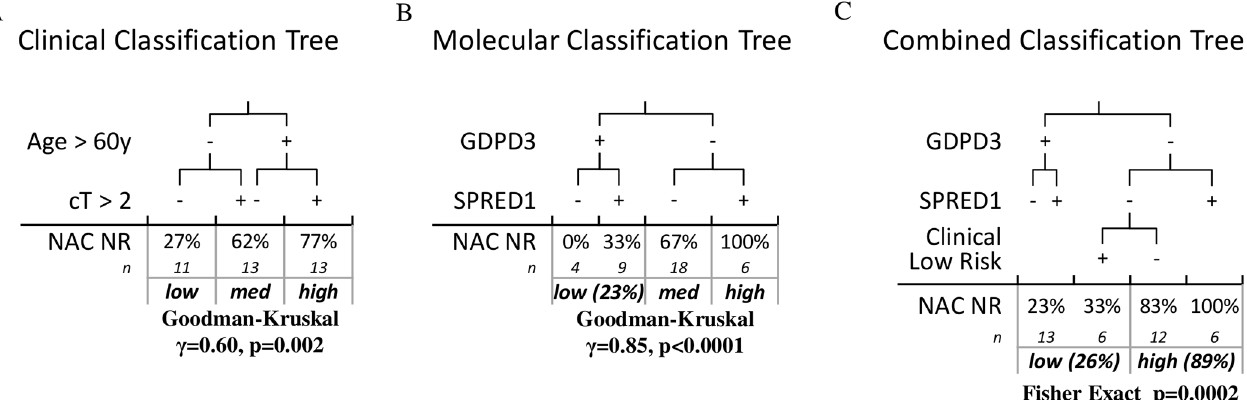
Fig 3. (A) The application of a previously developed classification tree based on the clinical parameters of age greater than 60 and clinical stage greater than cT2 is significantly associated with NR rate in the GC NAC TMA cohort. (B) A multivariate classification tree based on the IHC staining of GDPD3 and SPRED1 is also significantly associated with NR rate in the GC NAC TMA cohort. (C) A multivariate classification tree combining the IHC staining of GDPD3 and SPRED1 along with the relevant clinical factors (clinical low risk = age (cid:1) 60 & cT (cid:1) 2) simplifies the stratification of NAC resistance into two well separated